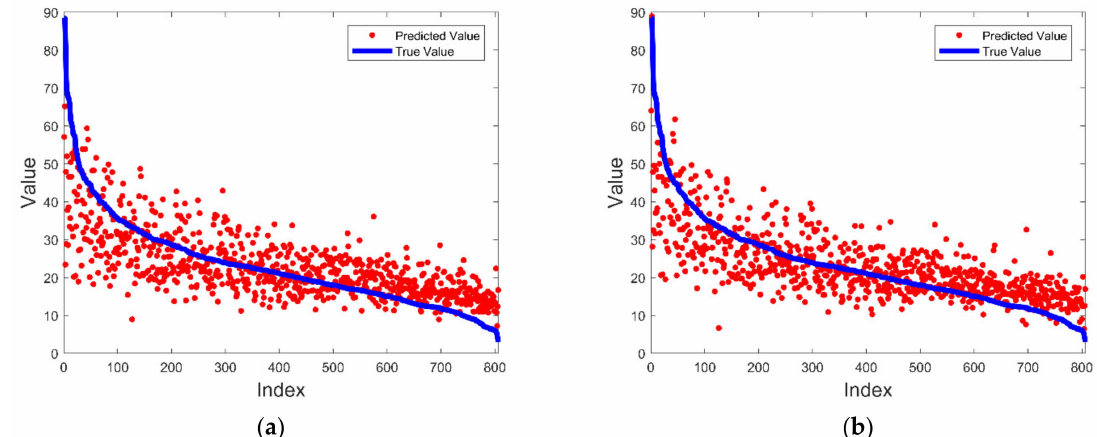
Figure 7. Real estate transactions dataset prediction results obtained with the models fused with the 0–1 type spatial weight matrix: ( a ) conventional LS-SVR model; ( b ) Geo LS-SVR model.